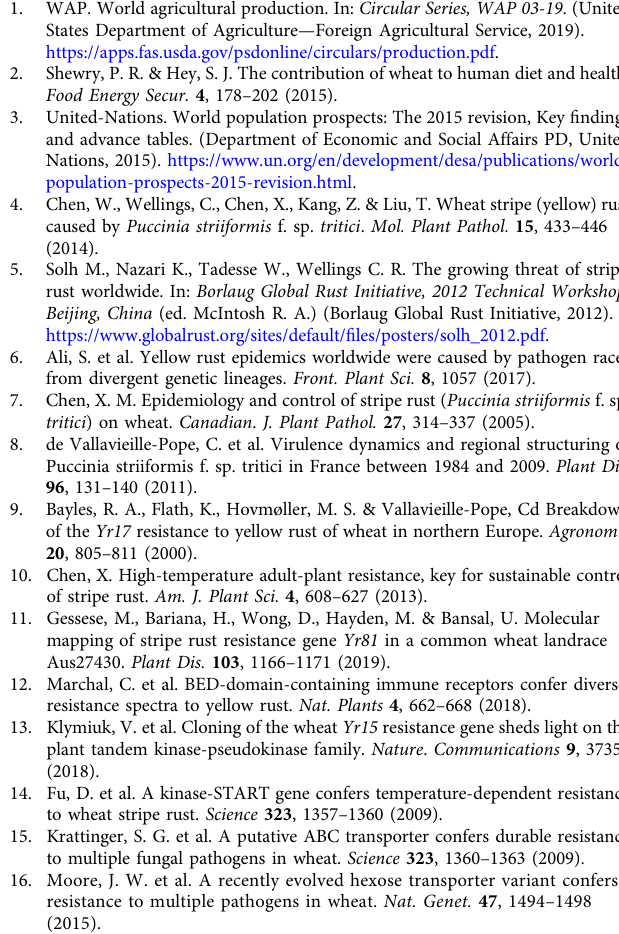
Haplotype analysis . Haplotype analysis was performed to understand the association of haplotypes and responses to Pst and the evolution of the YrAS2388 region. Haplotype markers (HTM) were speci fi cally designed for RLK 4DS-1 , RLK 4DS-2 and NLR 4DS-1 . Their physical locations (in Supplementary Tables 3 and 5, Supplementary Data 3) are counted from “ A ” in the start codon (ATG) in the genomic allele (GenBank accession number MK288012); for each marker, two periods separate the starting and ending nucleotides, and a minus sign indicates a backward count from “ A ” and a plus sign indicates a forward count from “ A ” . First, 159 Ae. tauschii accessions were genotyped in Sichuan, China using seven markers: HTM1a ( = RLK 4DS-1 ), HTM2a ( = RLK 4DS-2 ) and HTM3a to